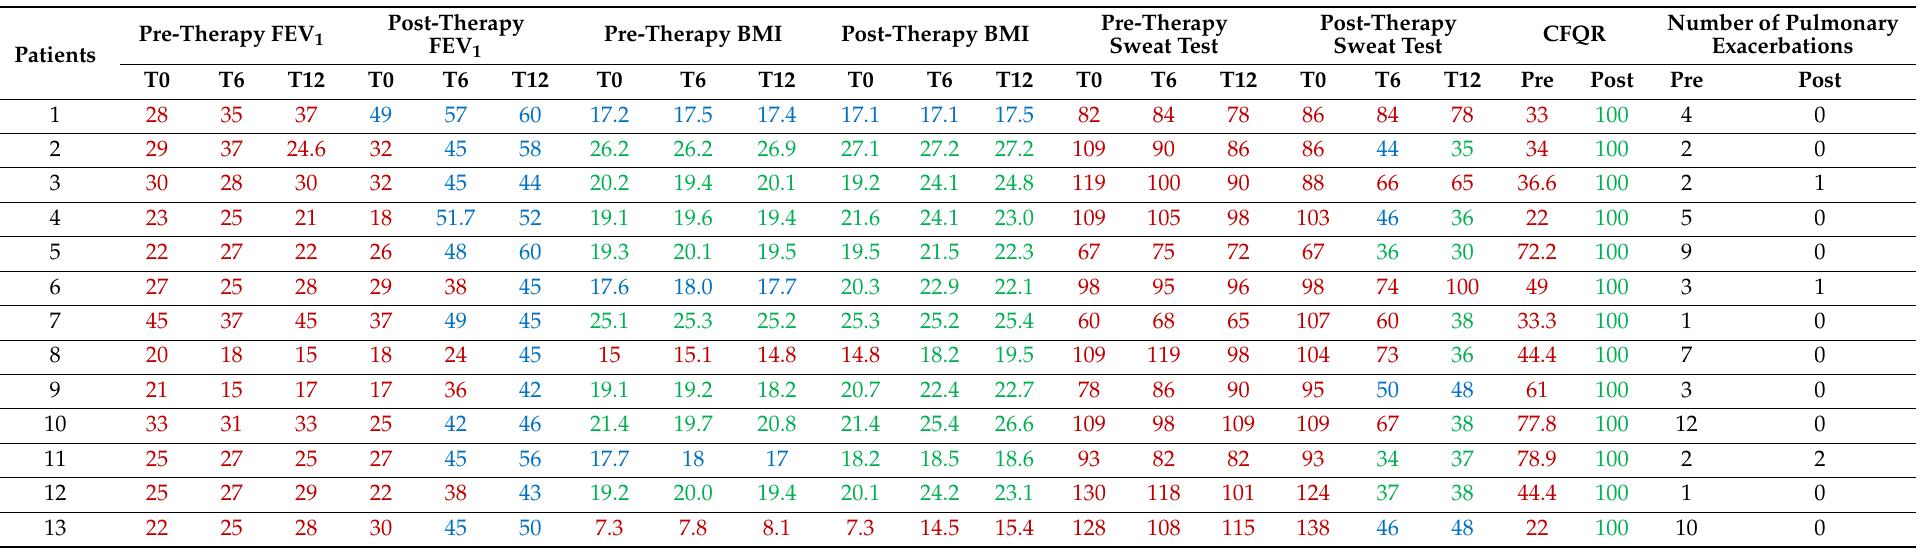
Table 2. Clinical data of case group